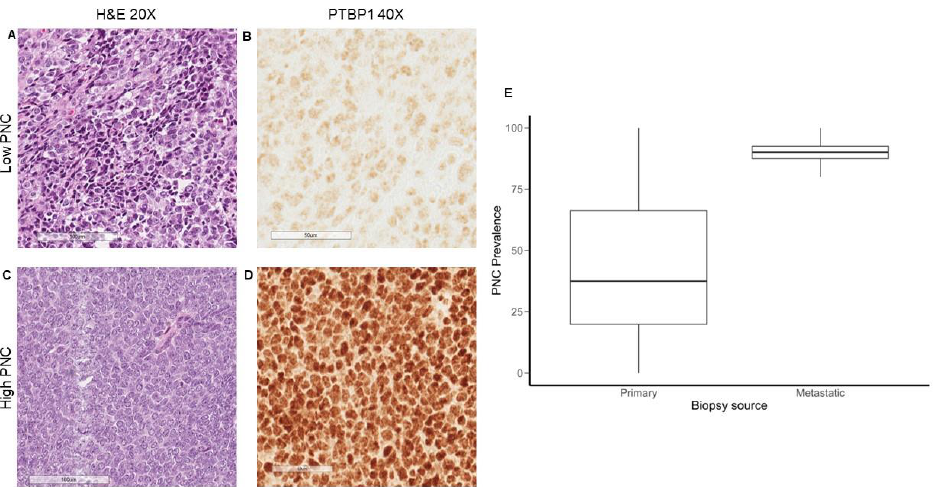
Figure 1. Prevalence of PNC in EWS tumor samples. Immunohistochemistry for PNC reveals distinct granular nuclear staining. While EWS tumors have the same histology (H&E X20 columns ( A , C )), they exhibit variable PNC staining that can be categorized as low ( B ) to high ( D ). ( B ) revealed less intensity and more restricted staining distribution compared to ( D ). The biopsy source demonstrates a higher PNC prevalence at metastatic sites from patients with relapse ( E ). Table 2. Ewing Sarcoma described risk factors by race.